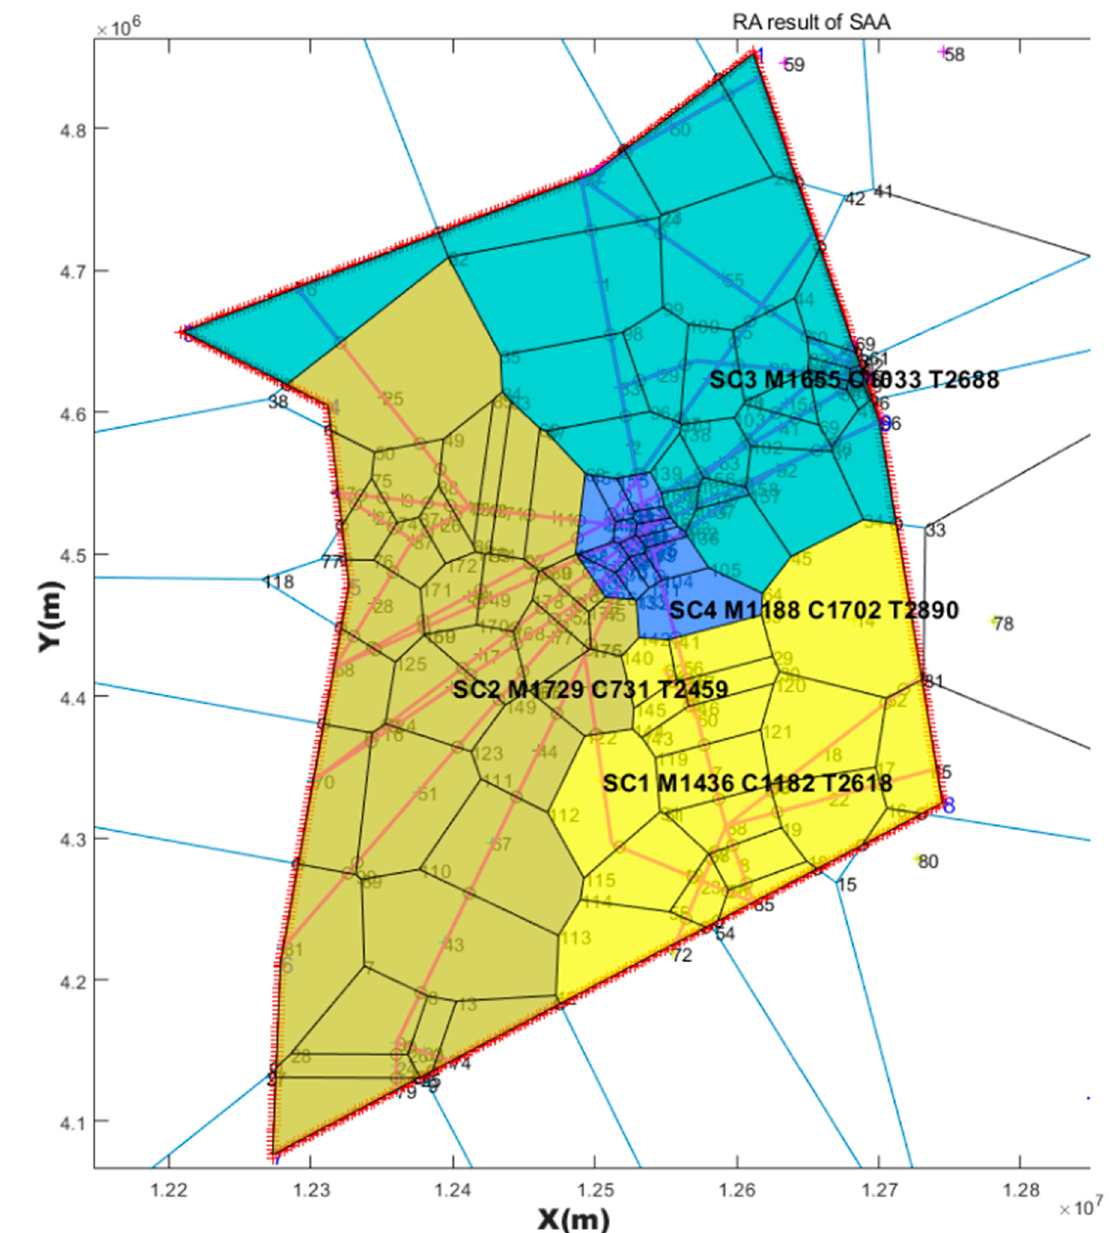
Figure 15. Reconfiguration results based on seeds every 50 km with SAA .